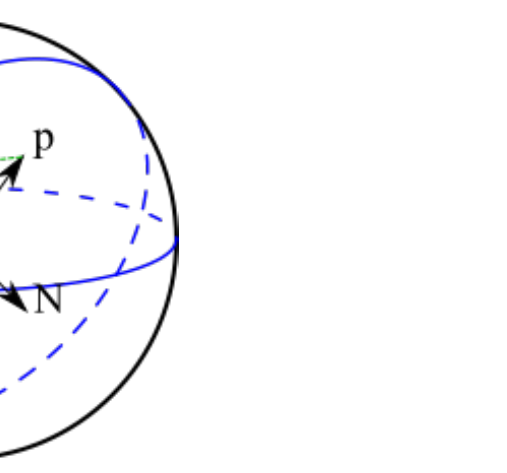
Figure A1. The red line is the great-circle arc connecting points v and w , and point p is the point in